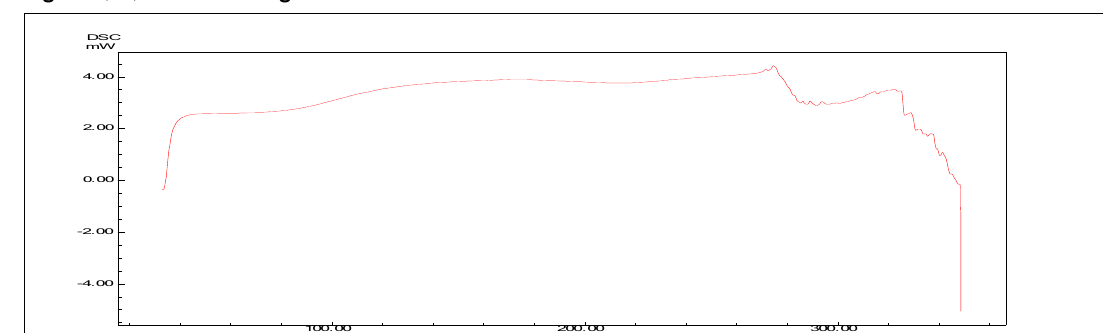
Figure (14) DSC thermogram of HPMC K15M